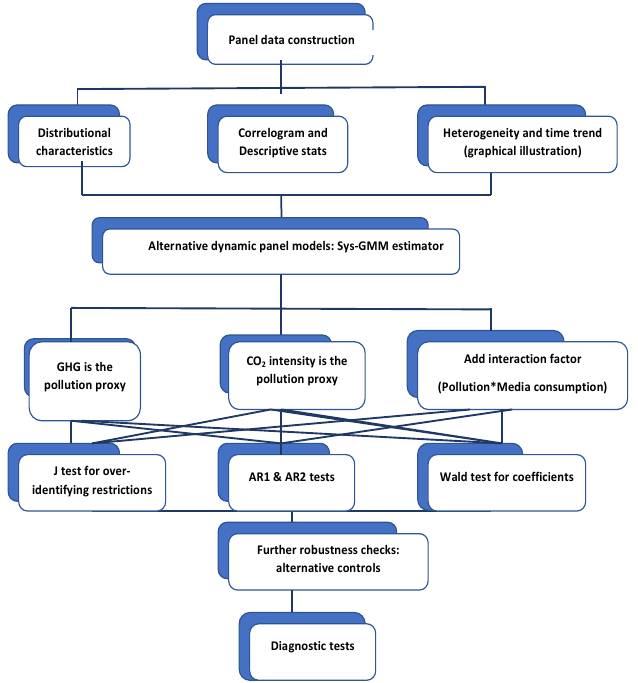
Figure 5. Overview of the implemented method. AR1 and AR2 represent the Arellano–Bond tests for first- and second-order autocorrelation in the idiosyncratic errors of the first-differenced